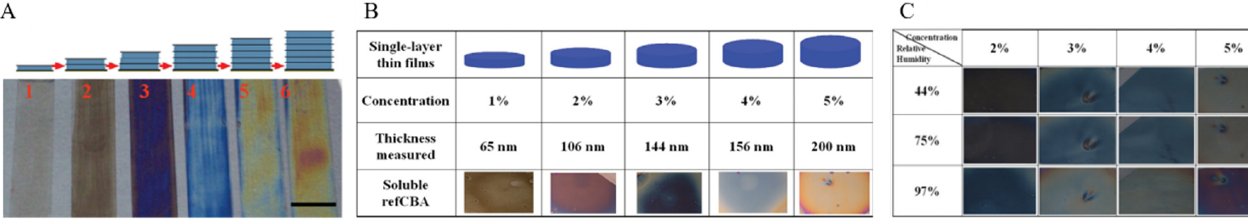
Figure 5. ( A ) RefCBA films of different layers (as red numbers in the figure) prepared by the spin- coating method; ( B ) RefCBA films of different thicknesses; ( C ) Dynamic color response of RefCBA